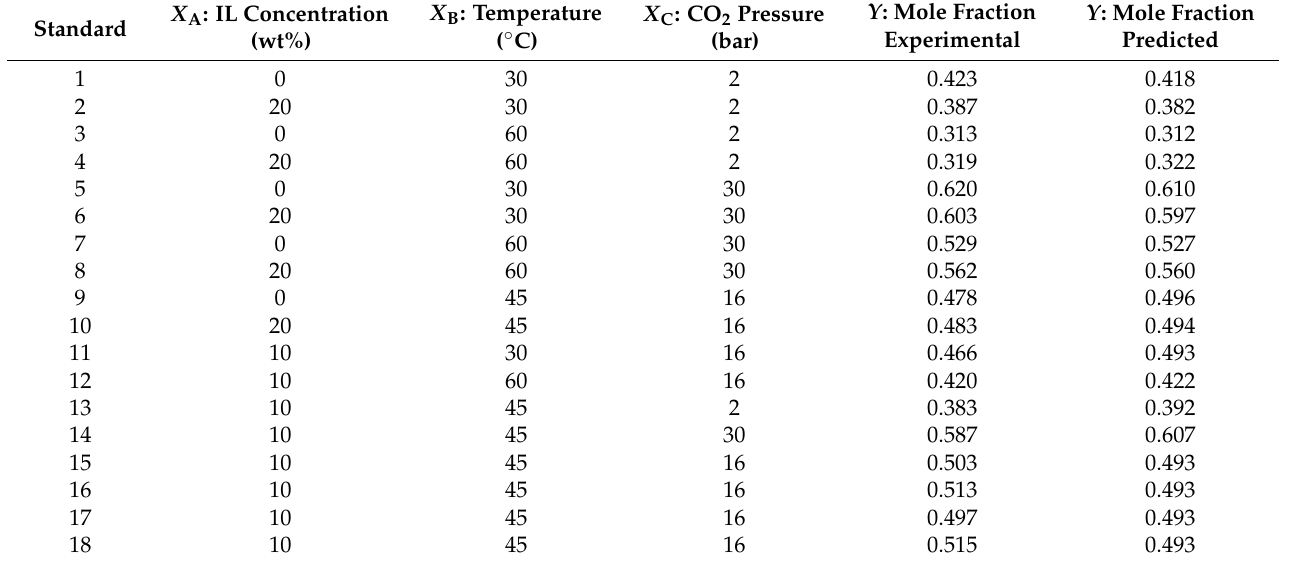
Table 4. The face-centered central composite design (FCCCD) design matrix and the mole fraction of